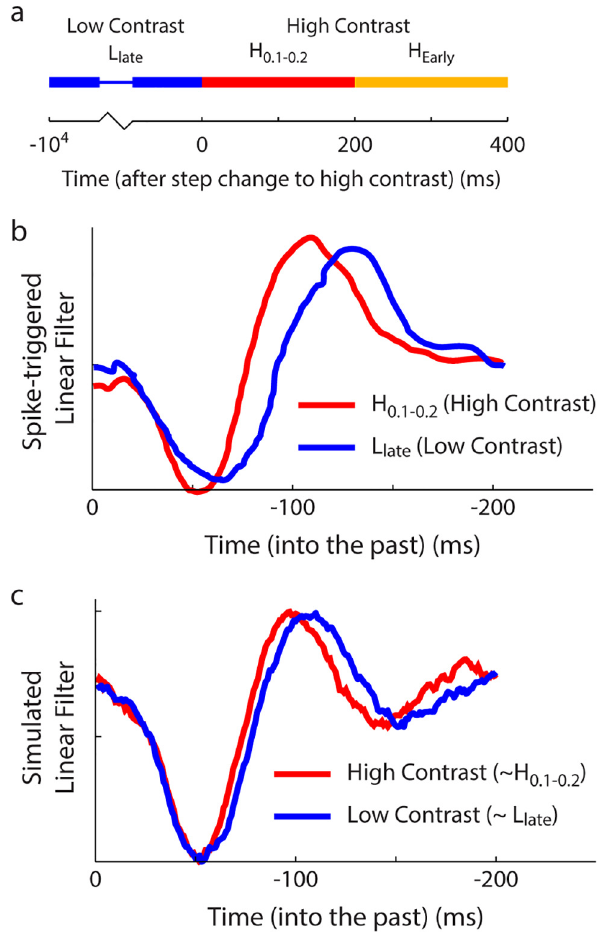
Fig 6. Linear filters from spike-triggered correlation analyses, estimated at different times around a sudden shift from low (L) to high (H) contrast. (a,b) Adapted from [27]. (a) Timeline of experiment. (b) Experimentally measured filters (low contrast, blue; high contrast, red). High contrast filter is computed only from the response to the first 200 ms of high contrast stimulus (see timeline in (a)). (c) Simulated response filters of the principal cell of the nonlinear predictive coding circuit (Methods), showing oscillatory structure.